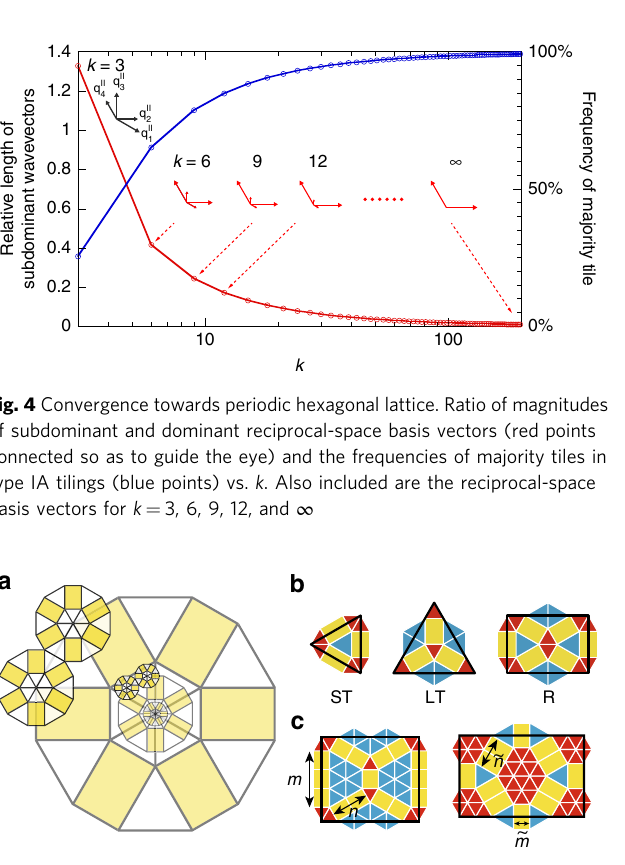
Fig. 5 Type II tilings. a Dodecagonal type IIA fundamental motif combined with four second-generation dodecagons and three third-generation dodecagon. Only the R tiles are colored so as to emphasize rotation by 30° upon subdivision; some are semitransparent for clarity. b Type IIA subdivision scheme. c Subdivision scheme for generalized type IIA and type IIB R tiles parametrized by ( m , n ) and ð ~ m ; ~ n Þ , respectively